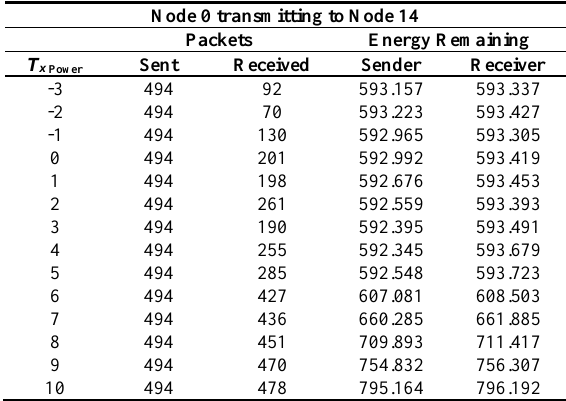
Table 17. Setting under Scenario 2c